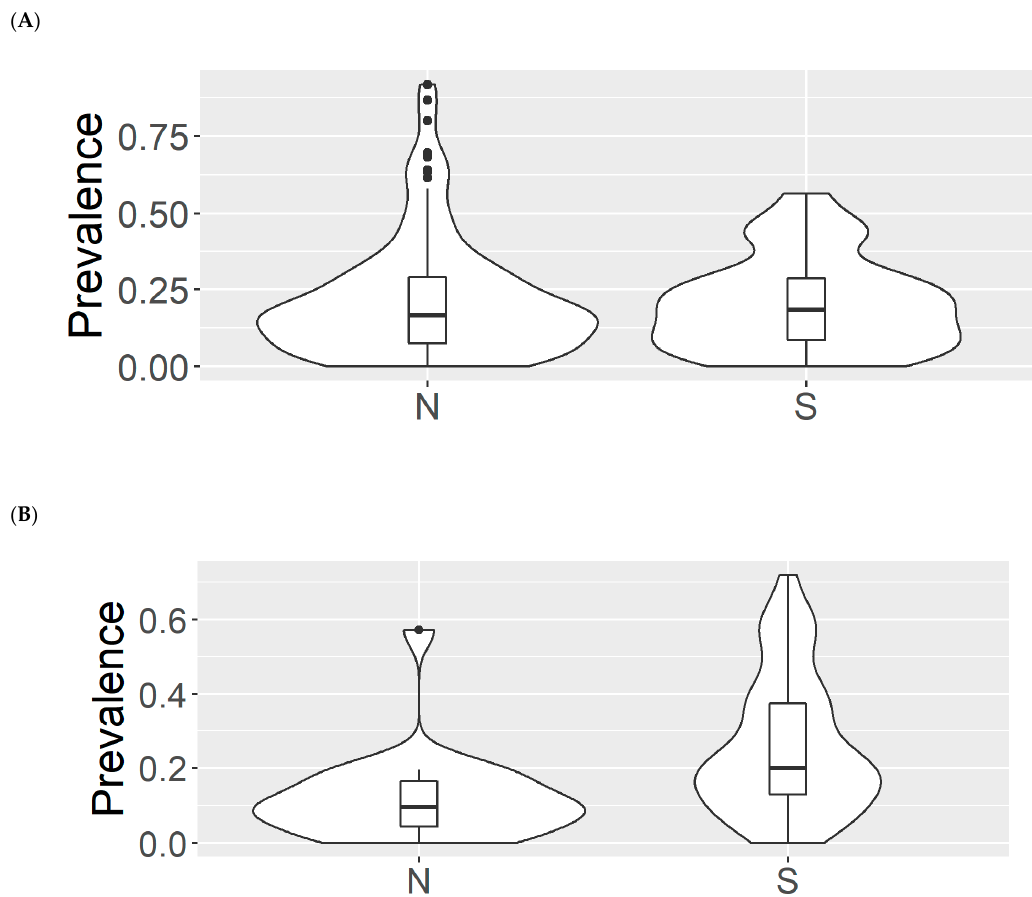
Figure 5. Violin plots showing the distribution of prevalence of acorns in the northern (>39 ◦ ) and southern (<39 ◦ ) latitudes for Q. rubra ( A ) and Q. alba ( B ) trees. The width of the violin plot indicates the density of the prevalence data. The box indicates the 50th percentile, the line indicates the median, and the whiskers contain the 95% confidence intervals. 3.2. Seed Size across a Latitudinal Gradient